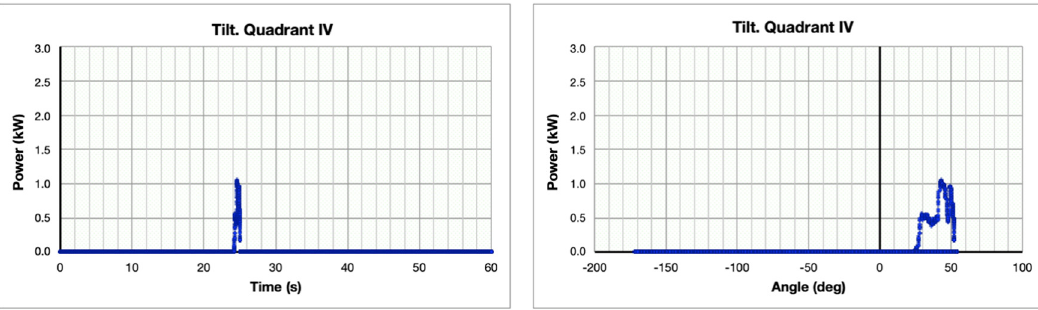
Figure 18. Recoverable power vs. time ( left ) and angle ( right ) for the tilt actuator in quadrant IV.